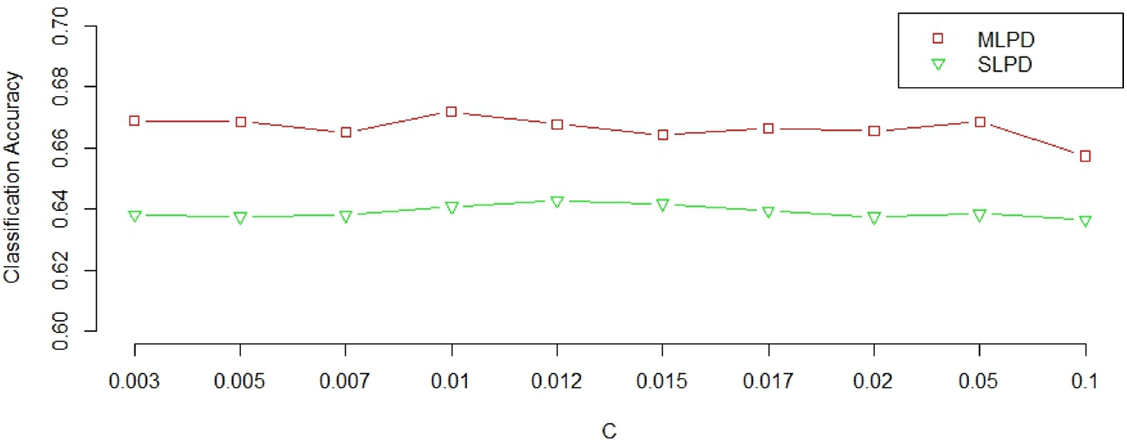
Figure 2. Classification accuracy of MLPD and SLPD with respect to different predefined threshold C